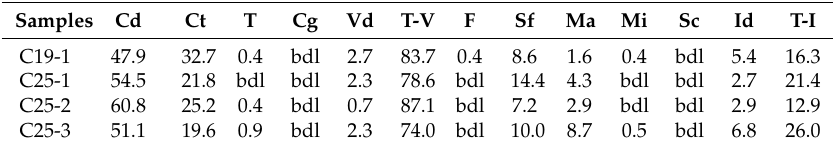
Table 2. Maceral composition (vol. %; on mineral-free basis) of the Shiping coals. Samples